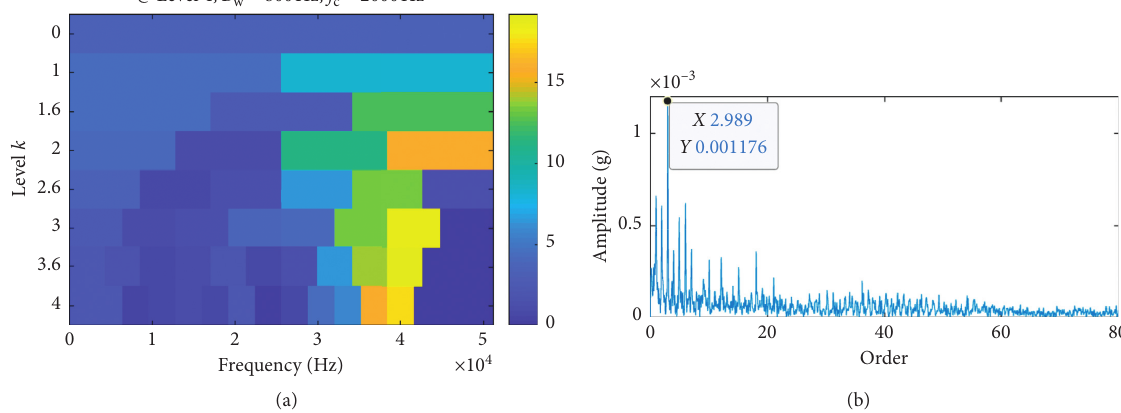
Figure 30: The analysis results for fault data of inner race by using NEA based on SK: (a) kurtogram; (b) envelope order